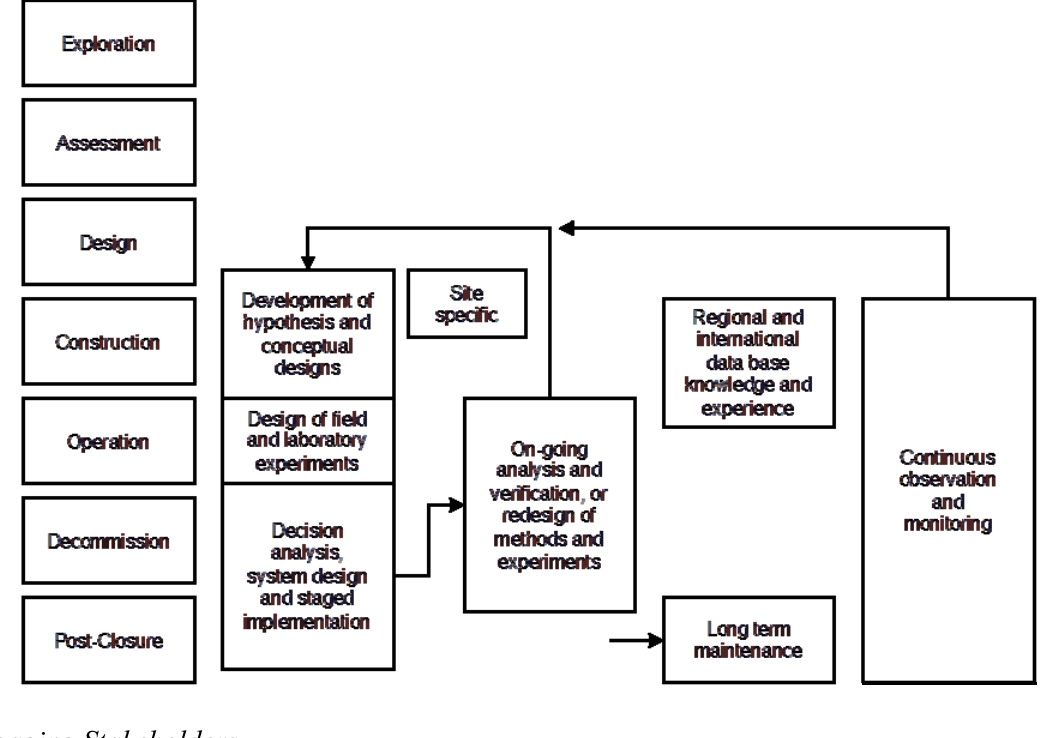
Figure 3. Adaptive Management Implementation by Phased Approach (from